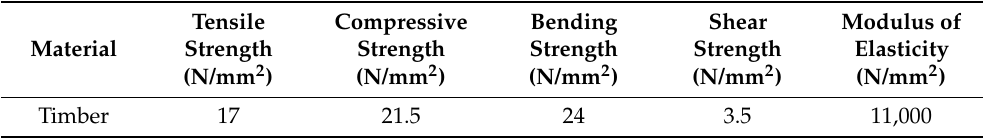
Table 1. The mechanical properties of glued laminated